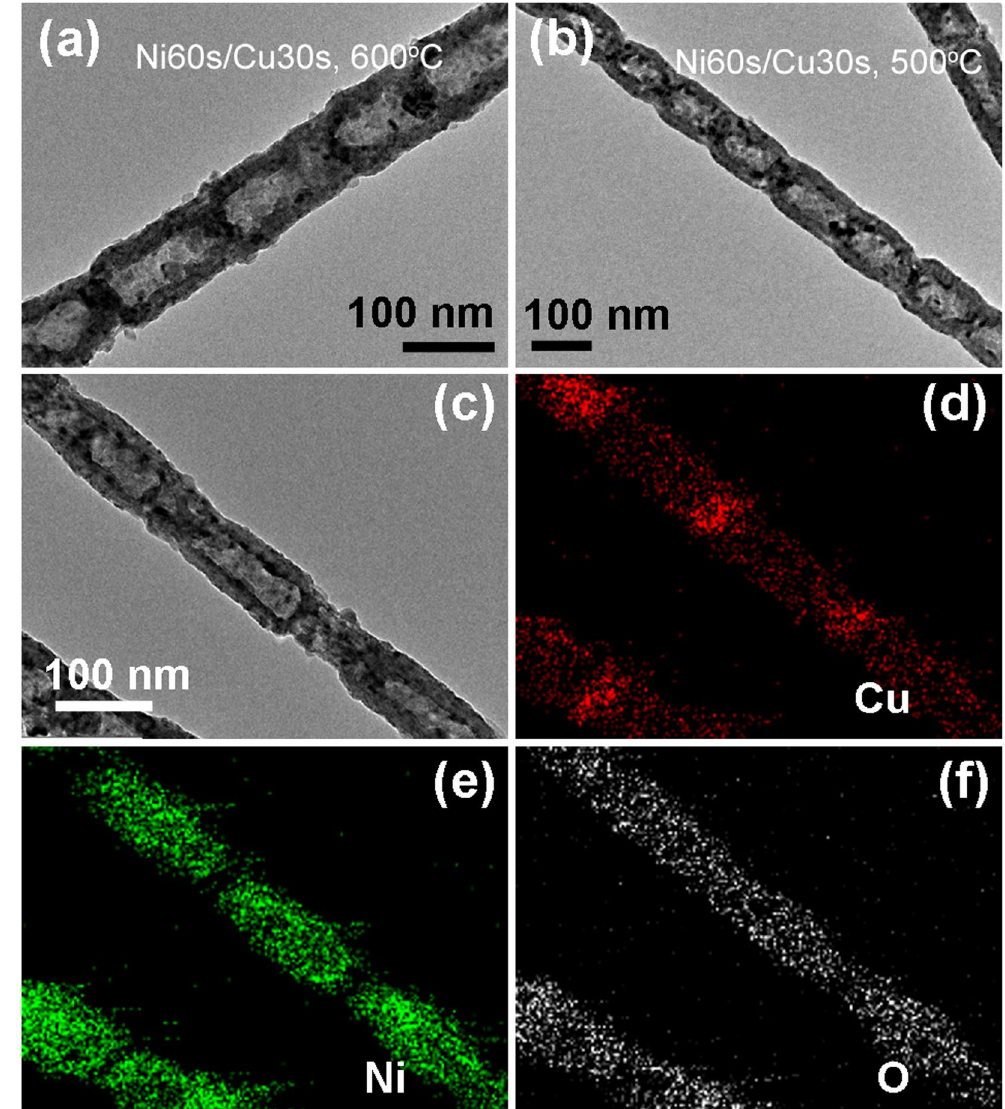
Figure 10. The Ni60s/Cu30s sample after annealing for 2 h. TEM images of the single annealed nanowire ( a ) at 600 °C; ( b ) at 500 °C; ( c – f ) the magnified TEM image and the corresponding EDS elements mapping